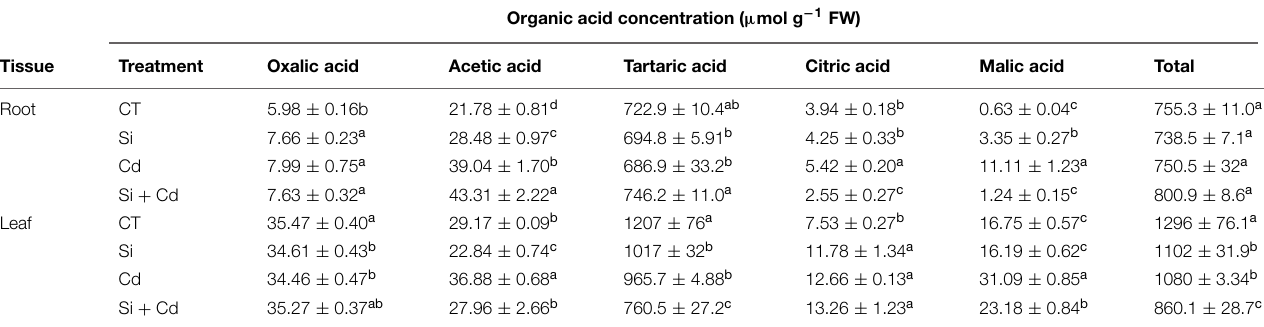
TABLE 4 | Effect of Si on organic acids concentrations in tomato seedlings under Cd toxicity.